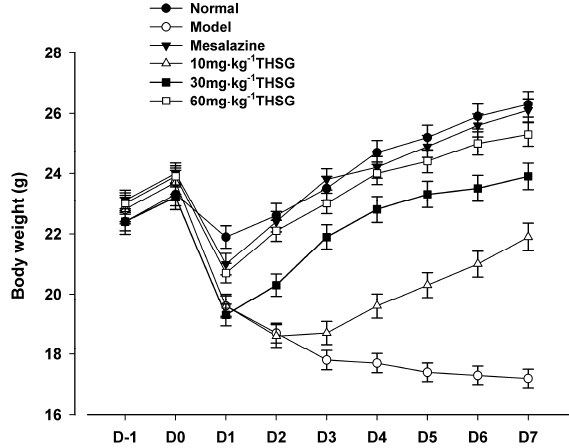
Figure 2. Effect of THSG on mice body weight loss caused by experimental colitis induced by acetic acid. Values are means ± SEM (n = 12 for each